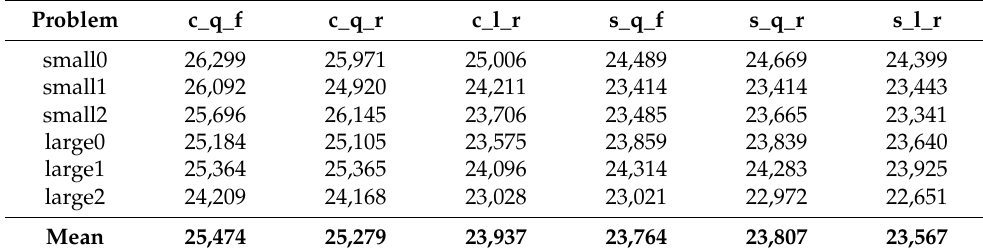
Table 3. Optimization results with different settings on six problem instances, with a time limit of 15min for the total